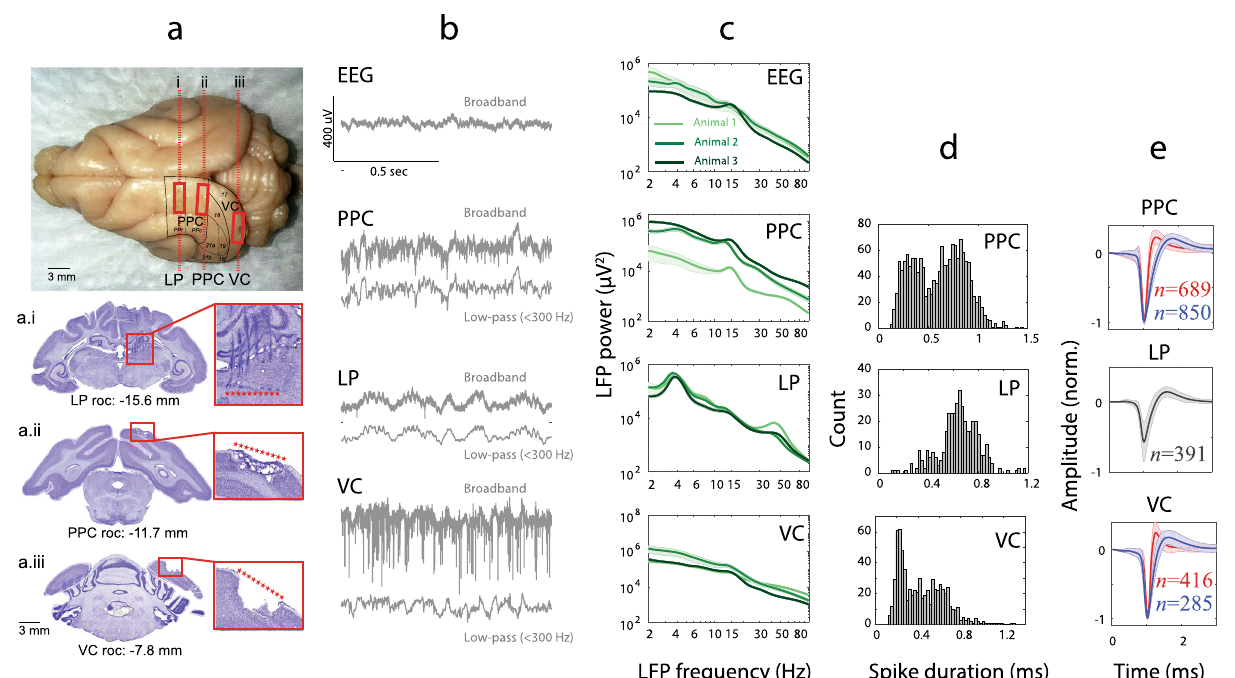
Fig. 1 Histology and endogenous alpha-band oscillations in awake head- fi xed ferrets. Histology veri fi cation of implant locations. a Ferret brain with marks (highlighted by rectangles) left by microelectrode array implants in LP, PPC, and VC regions. Outlines of cortical fi elds are based on a published ferret neuroanatomical atlas 67 . Dashed lines indicate the location of cell-stained coronal cross-sections through the center of the multi-electrode array implanted sites shown below (i – iii). Corresponding anterior – posterior atlas coordinates are indicated below each section in mm, relative to the occipital crest. a.i Coronal cross-section through the LP implant region shows implant electrode tracks and endpoints (dark spots of cell agglomerations above red stars). a.ii Coronal cross-section through the PPC implant region demonstrates the tissue damage at the site of the electrode array caused by the removal of the implant during brain extraction (below red stars). a.iii Coronal cross-section through the VC implant region marked by tissue loss (below red stars) caused by the removal of the implant during brain extraction after completion of the experiment. “ roc ” indicates “ reference to occipital crest ” . b Sample 1-s length EEG, broadband extracellular recordings and local fi eld potential signals (LFPs) from the posterior parietal cortex (PPC), visual cortex (VC), and lateral posterior nucleus/Pulvinar complex (LP) from a head- fi xed awake ferret (resting state, no task performed by animal). c Spectral analysis of EEG and LFPs showing the spectrum (mean ± SEM) with error bars in the light background from three animals (each animal in a different shade of green). The scalp EEG signal demonstrated a weak alpha-band peak for all animals. PPC showed clear alpha-band activity (12 – 16 Hz) for all animals. LP showed prominent theta, gamma (35 – 50 Hz), and a weak alpha activity for all animals. A weak alpha-band activity is also evident for the visual cortex (VC) for all three animals. A closer look at PPC spectra indicates slight differences in the individual alpha frequency between animals (14.42, 12.32, 14.42 Hz for animals 1, 2, and 3 respectively). d Histogram of spike duration was de fi ned as the time from trough to peak in PPC, LP, and VC. e Color-coded spike waveforms (mean ± SEM) were calculated for two identi fi ed clusters of narrow-spiking (red, n = 689 in PPC, n = 416 in VC) and broad-spiking (blue, n = 850 in PPC, n = 285 in VC) neurons in PPC and VC. LP neurons comprised only one cluster ( n = Population coupling is stronger for narrow-spiking neurons weaker theta-band (3 – 8 Hz) oscillation was also evident in all and oscillates at alpha frequency . We recorded broadband regions [de fi ned as an increase above background noise]. Com- extracellular activity from cortical and thalamic regions and the paring the narrow- and broad-spiking neurons, we found that EEG signal to measure endogenous oscillations. This recording narrow-spiking neurons had stronger population coupling than enabled us to examine the interaction between neural activity at broad-spiking neurons (Fig. 2d – f, amplitudes at time lag zero), the level of single units and network activity at the level of the and the fl uctuation of the coupling had more oscillatory power LFP or EEG to better understand the underlying mechanisms of over a wide frequency range including the alpha band in both the endogenous oscillations. We fi rst asked if there was a rela- PPC and VC (Fig. 2d – f). tionship between single-unit activity and the local dynamics in each region by measuring population coupling 44 . We constructed the population fi ring rate function for each region of interest Alpha synchronization between EEG and spikes, and promi- (ROI) based on its spiking activity. Spike-triggered average nent engagement of narrow-spiking neurons . Next, we exam- population fi ring rates were extracted at the occurrence of indi- ined alpha synchrony at the network scale by quantifying the vidual spikes for all unit types by region and given as a percentage synchronization between single units in all three ROIs and EEG of the baseline value in the 500 ms before spike generation. The oscillations. The average spike-triggered EEG showed an oscilla- within-region average of this value provided a measure of how tory pattern at alpha-frequency band (Fig. 2g – i). Further analysis strongly each unit was coupled to local oscillations (Fig. 2a – c) 44 . showed a non-uniform phase histogram for each region (Fig. 2j – l). Narrow-spiking PPC units preferred to spike at 174.67°, con fi dence interval (CI) = [172.71°, 176.63°] phase of EEG alpha oscillations. The preferred phase for broad-spiking (11 – 17 Hz) frequency band for all three regions (Fig. 2d – f). A neurons was 173.14°, CI = [170.95°, 175.32°]. For VC neurons,